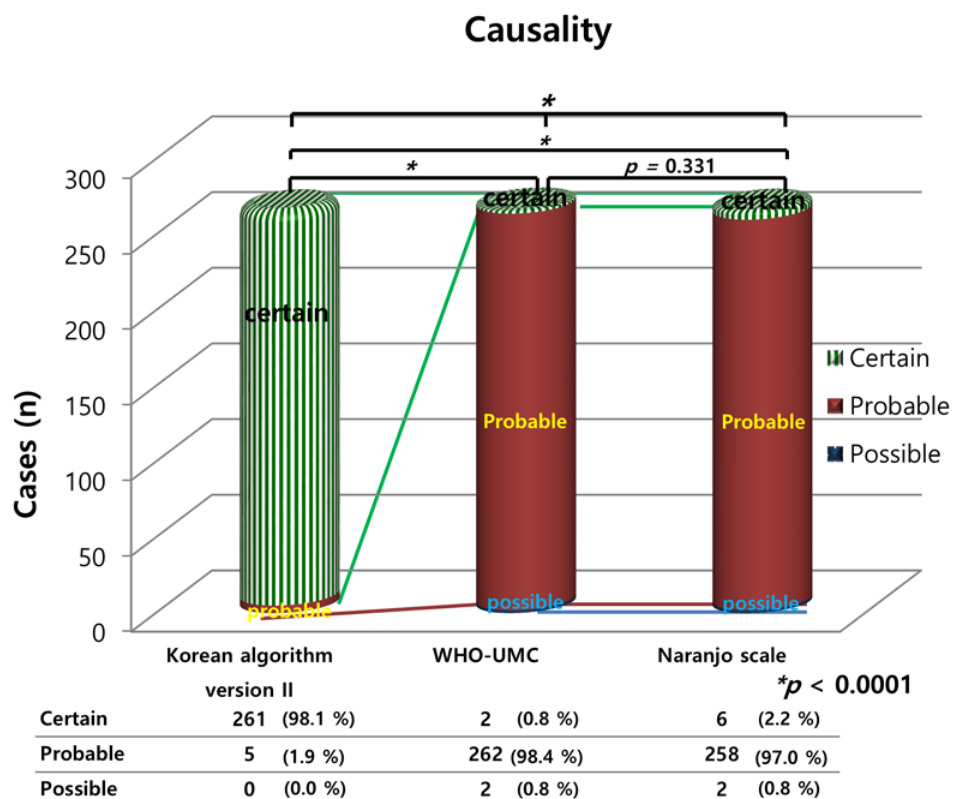
Fig 2. The characteristics of contrast media-induced adverse reactions: causality versus evaluation tool. WHO-UMC, World Health Organization- Uppsala Monitoring Centre; CM-ADRs, contrast media-induced adverse drug reactions; * chi square test.